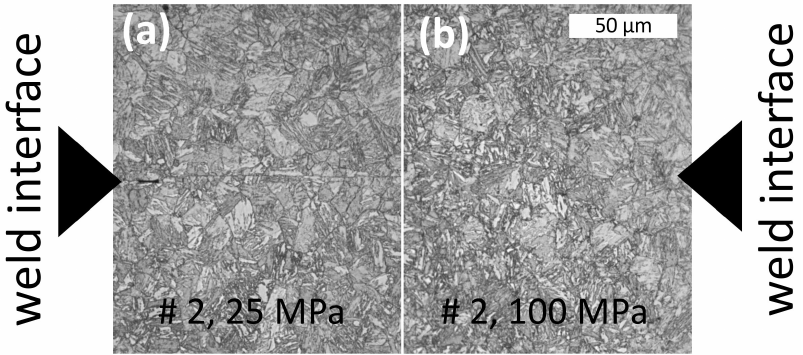
Figure 27. ( a ) Micrograph of the cross-section from the sample with surface machining # 2 after diffusion bonding by one HIP cycle at 25 MPa/1050 ◦ C/2 h. In this case, the weld surface (indicated by the black arrows) is still recognizable; ( b ) The same cross-section after a second HIP cycle at 100 MPa/1050 ◦ C/2 h. The weld surface cannot be identified